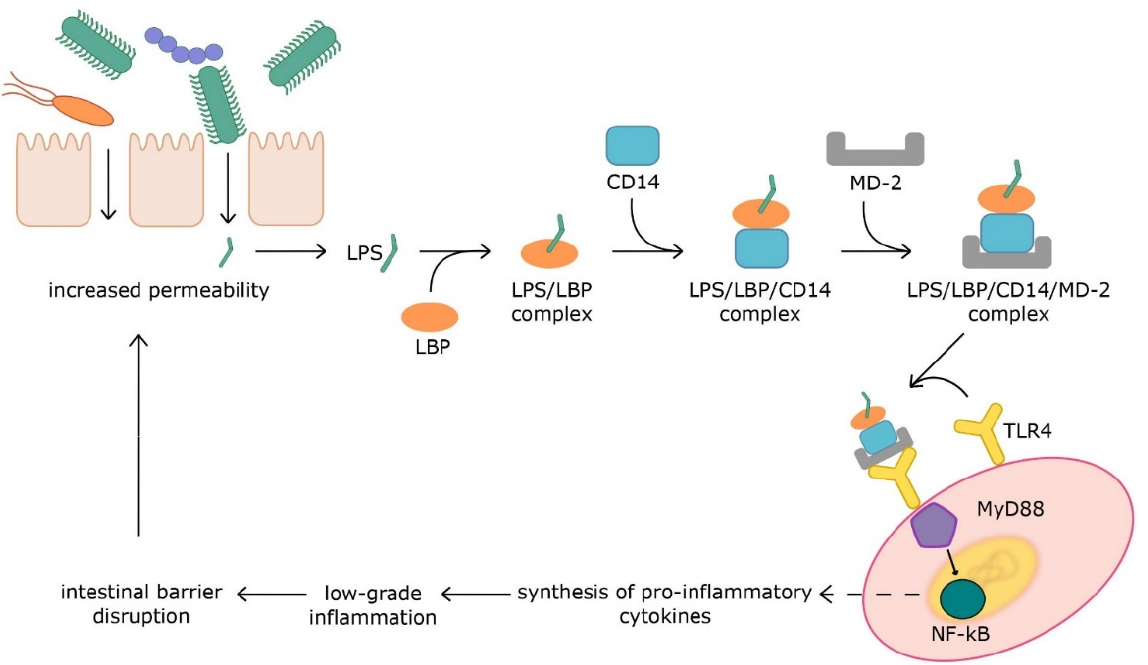
Figure 1. Mechanism of LPS’ influence on inflammation and intestinal permeability. Aberrations: